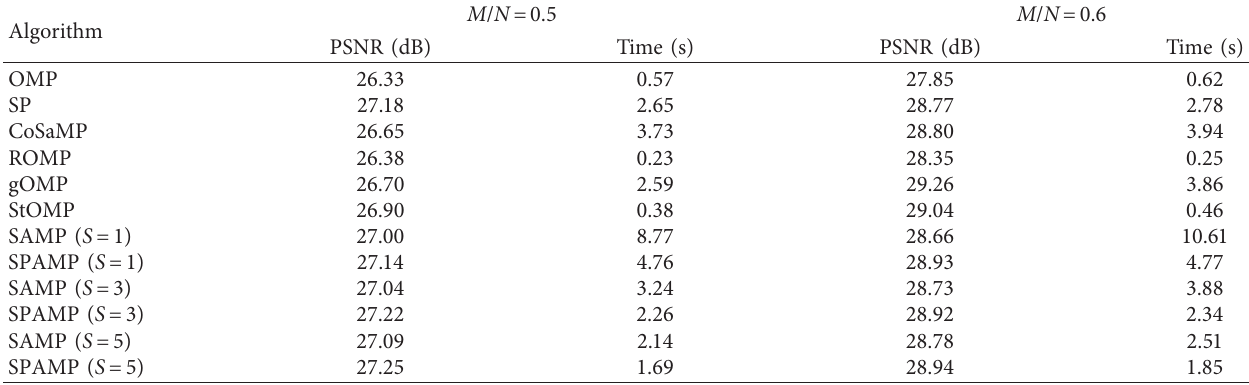
Table 1: PSNR and runtime comparison of different